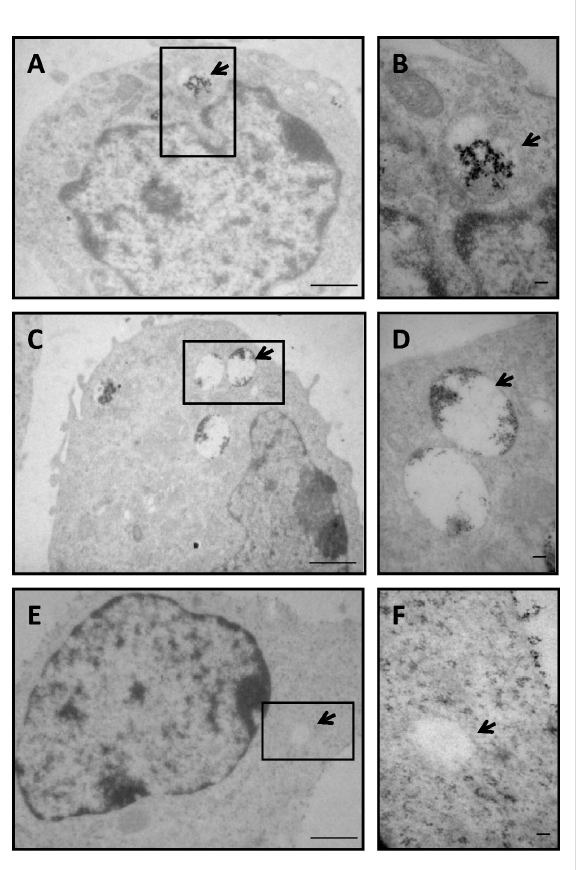
Figure 6: Macropinocytotic vesicle containing PLL- γ -Fe 2 O 3 and nanomag ® -D-spio nanoparticles. Transmission electron micrographs of NSCs labeled with PLL- γ -Fe 2 O 3 (PLL, A, B) and nanomag ® -D-spio (NM, C, D) nanoparticles, and unlabeled controls (E, F). Arrows indi- cate the macropinocytotic vesicles. Insets show macropinocytotic vesi- cles. Scale bar: 1 µm. lular vesicle trafficking), phenylarsine oxide (inhibits the clathrin-mediated endocytotic pathway) and filipin (inhibits caveolae pathways). Flow cytometry analysis showed